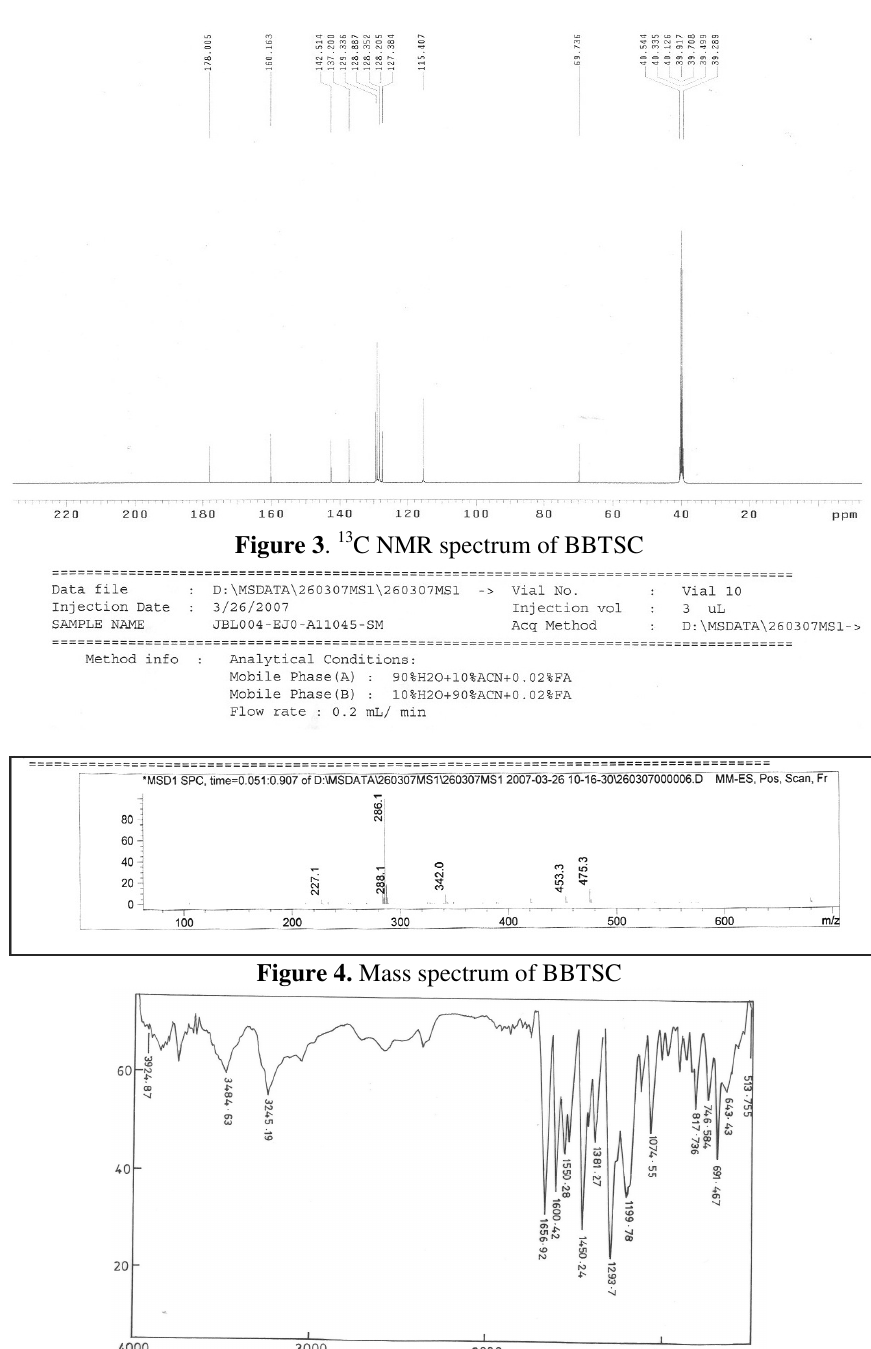
Figure 5. IR SPECTRUM of 3,